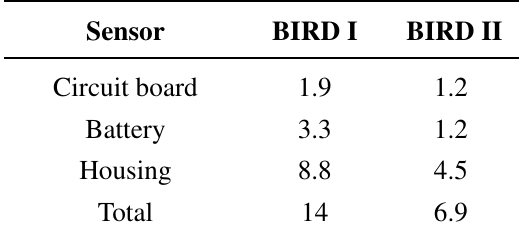
Table 2. Weight distribution of BIRD I and BIRD II